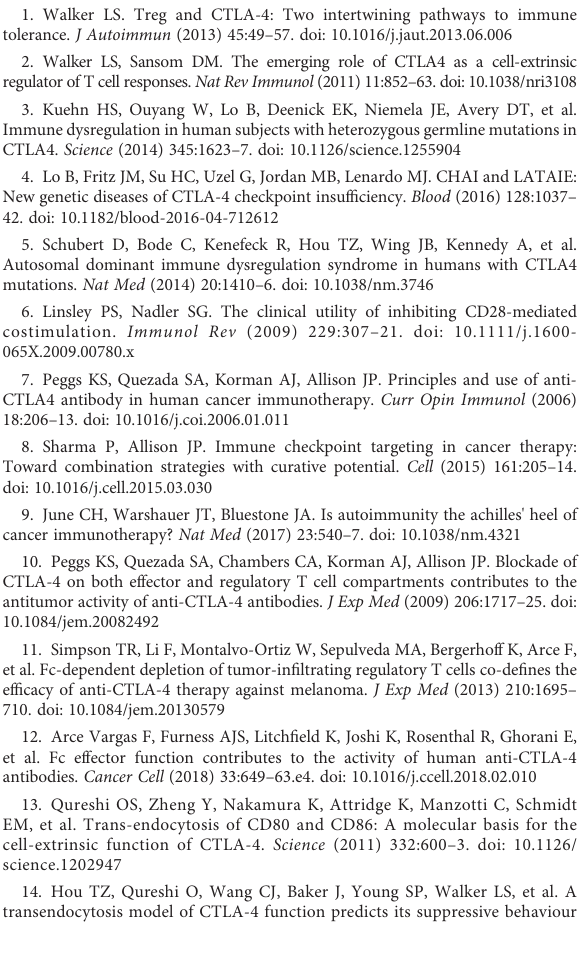
secondary Ab for 30 minutes on ice. LH panel shows representative FACS plots and RH panels show aggregate data for CTLA-4 binding (MFI) from3 independent experiments. (C) CTLA4 expressing or non-expressing Jurkat cells were stained directly with PE-conjugated anti-CTLA-4 Abs on ice for 30 minutes and analysed by fl ow cytometry. LH panel shows representative FACS plots and RHpanels show aggregate data for CTLA-4 binding (MFI) from >10 independent experiments.